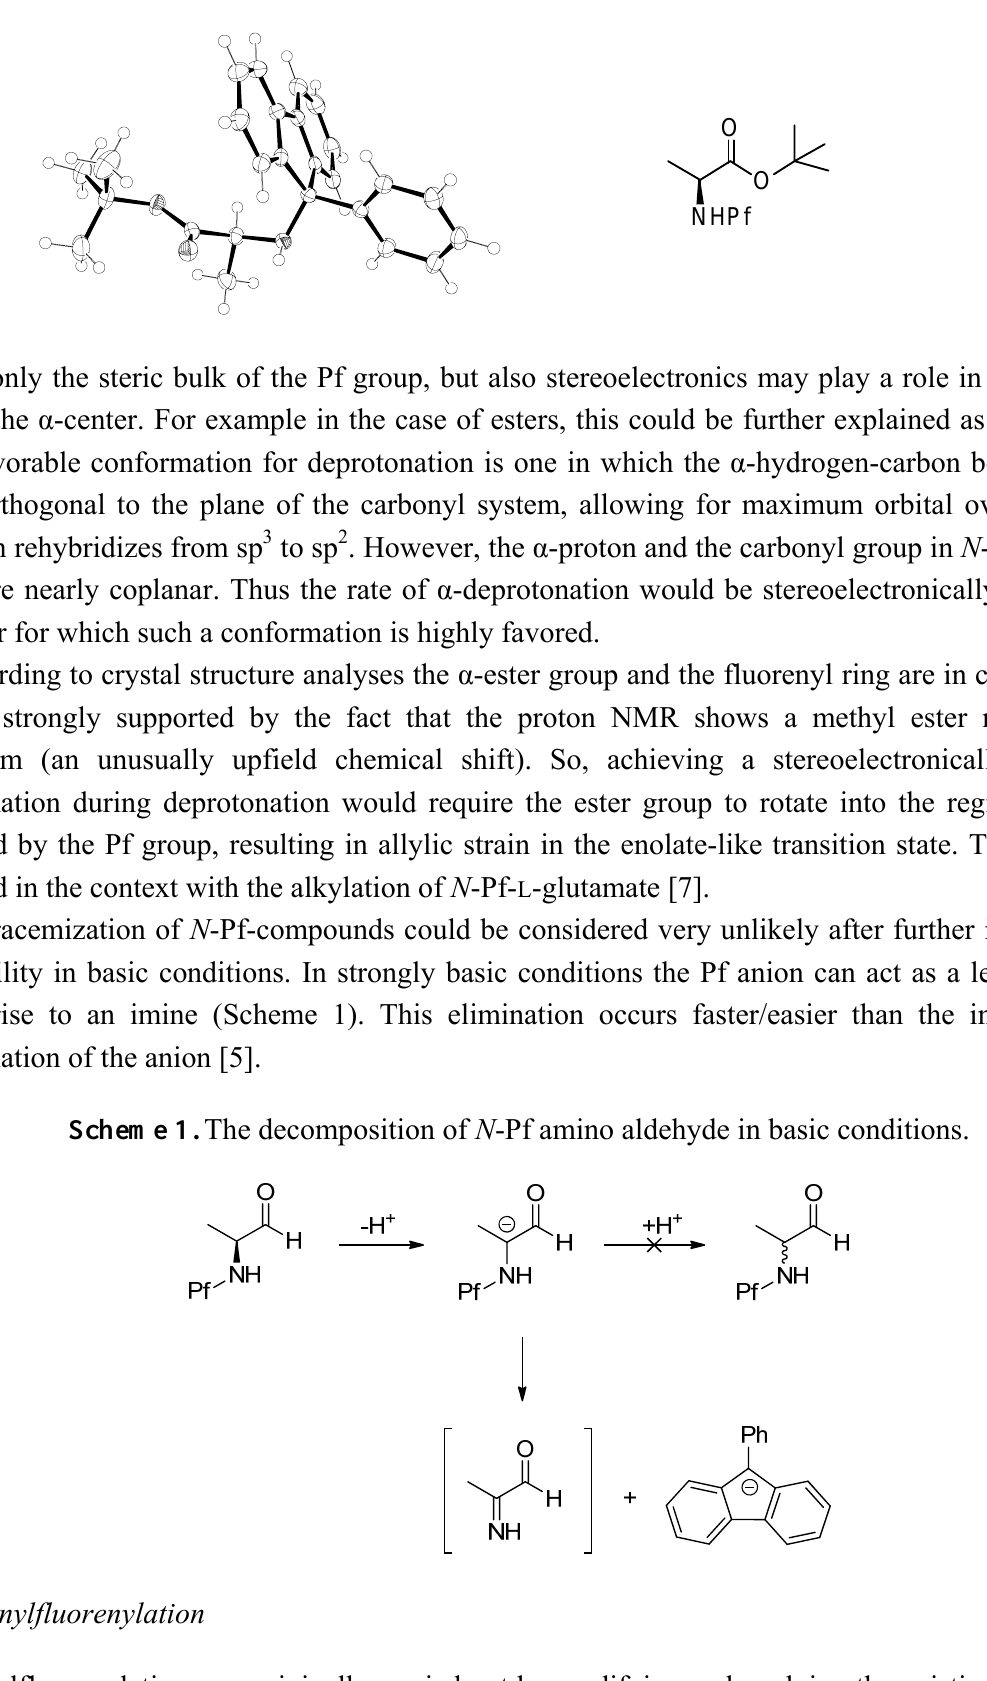
Figure 2. Crystal structure of N -Pf alanine tert -butyl ester